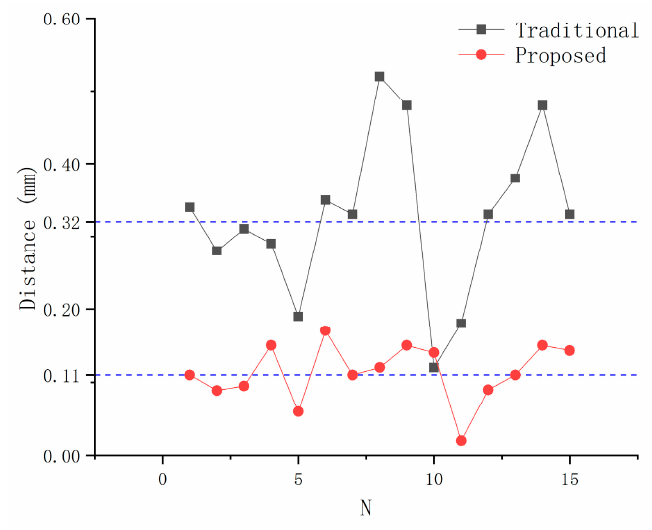
Figure 17. Comparison TCPP error.